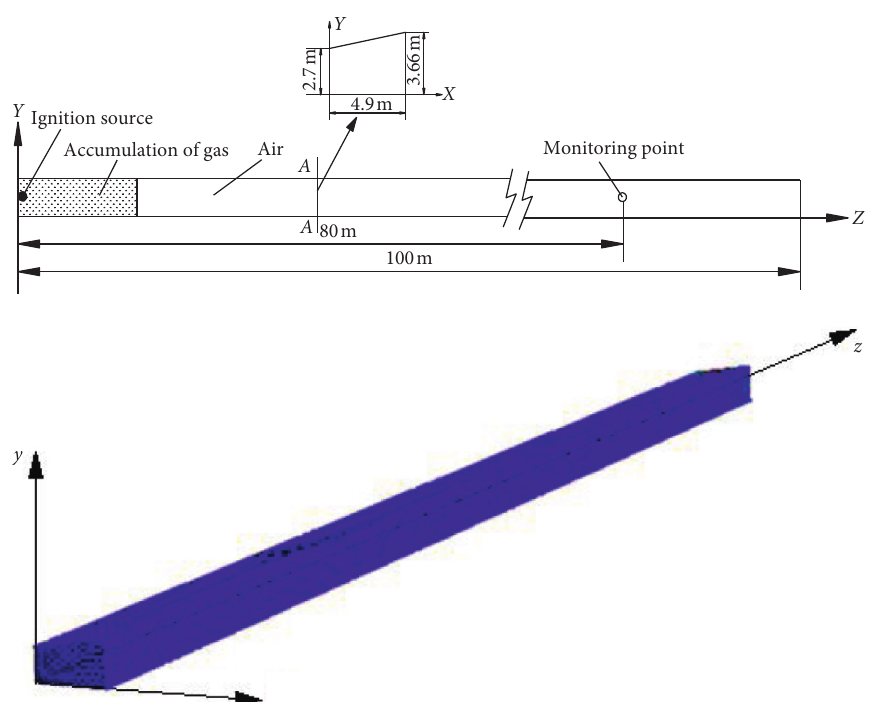
Figure 3: Geometric model diagram of driving surface. (a) Schematic diagram of geometric model of driving surface. (b) 3D model diagram of driving surface.